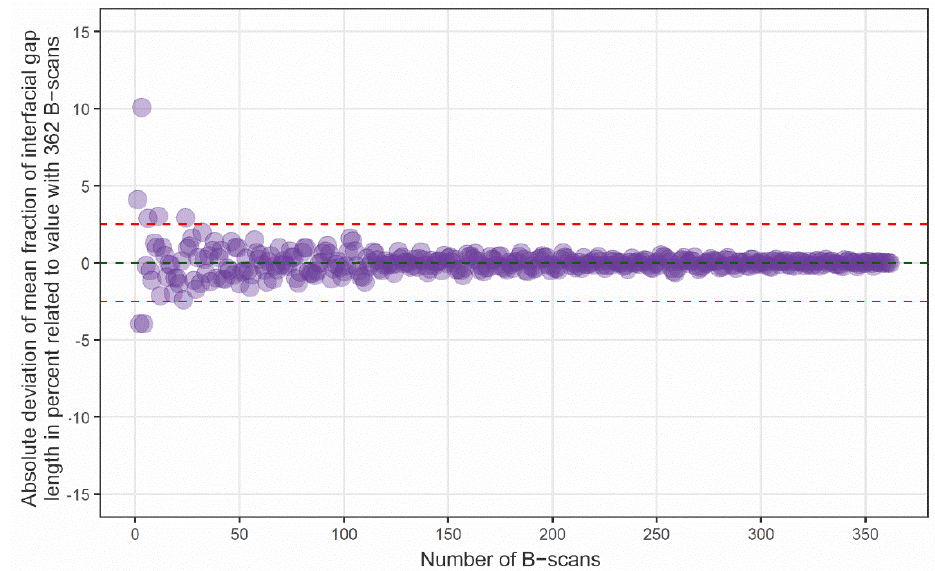
Figure 3. Approximation for the weighted mean fraction of interfacial gap length on dentin, based on all 362 B-scans of the volume scan exemplarily for tooth 24. The approximation of the true mean with N → ∞ becomes clear.